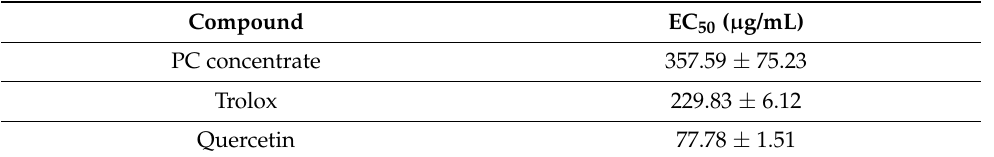
Figure 6. Percentage of reduced DPPH after adding of different concentrations of polyphenols from PC concentrate, trolox and quercetin. Table 3. Half maximal effective concentration (EC 50 ) for PC concentrate, trolox and quercetin for DPPH radical scavenging